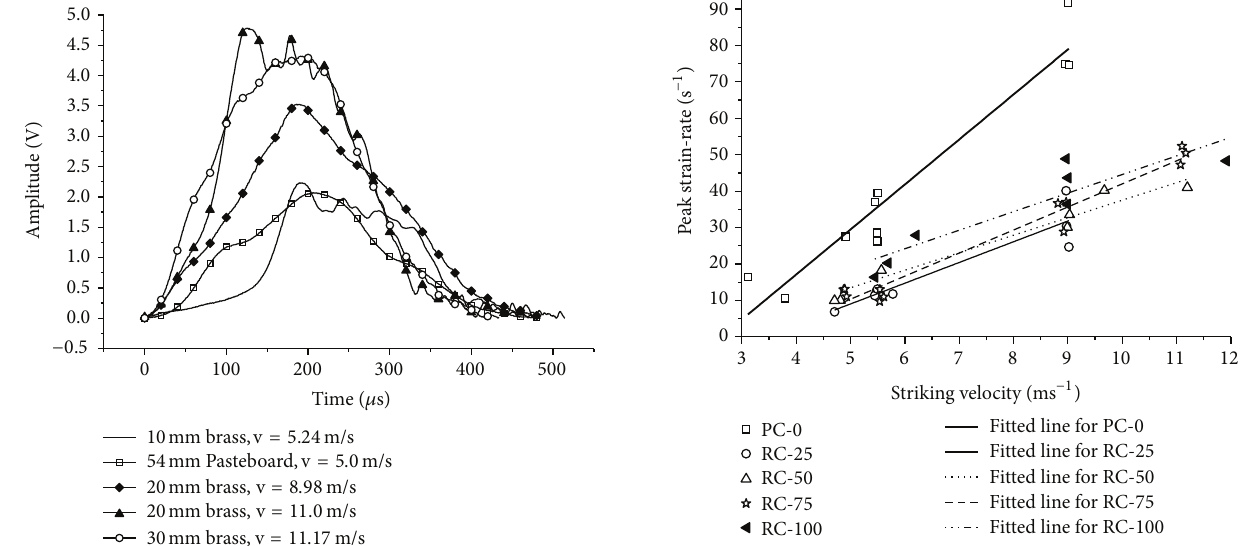
Figure 3: Incident waveforms shaped with different pulse shapers. each test, a random pattern with good contrast was applied to the surface of the specimen. This pattern deforms with the sample. The tensile stress-strain curves are shown in Figure 2.